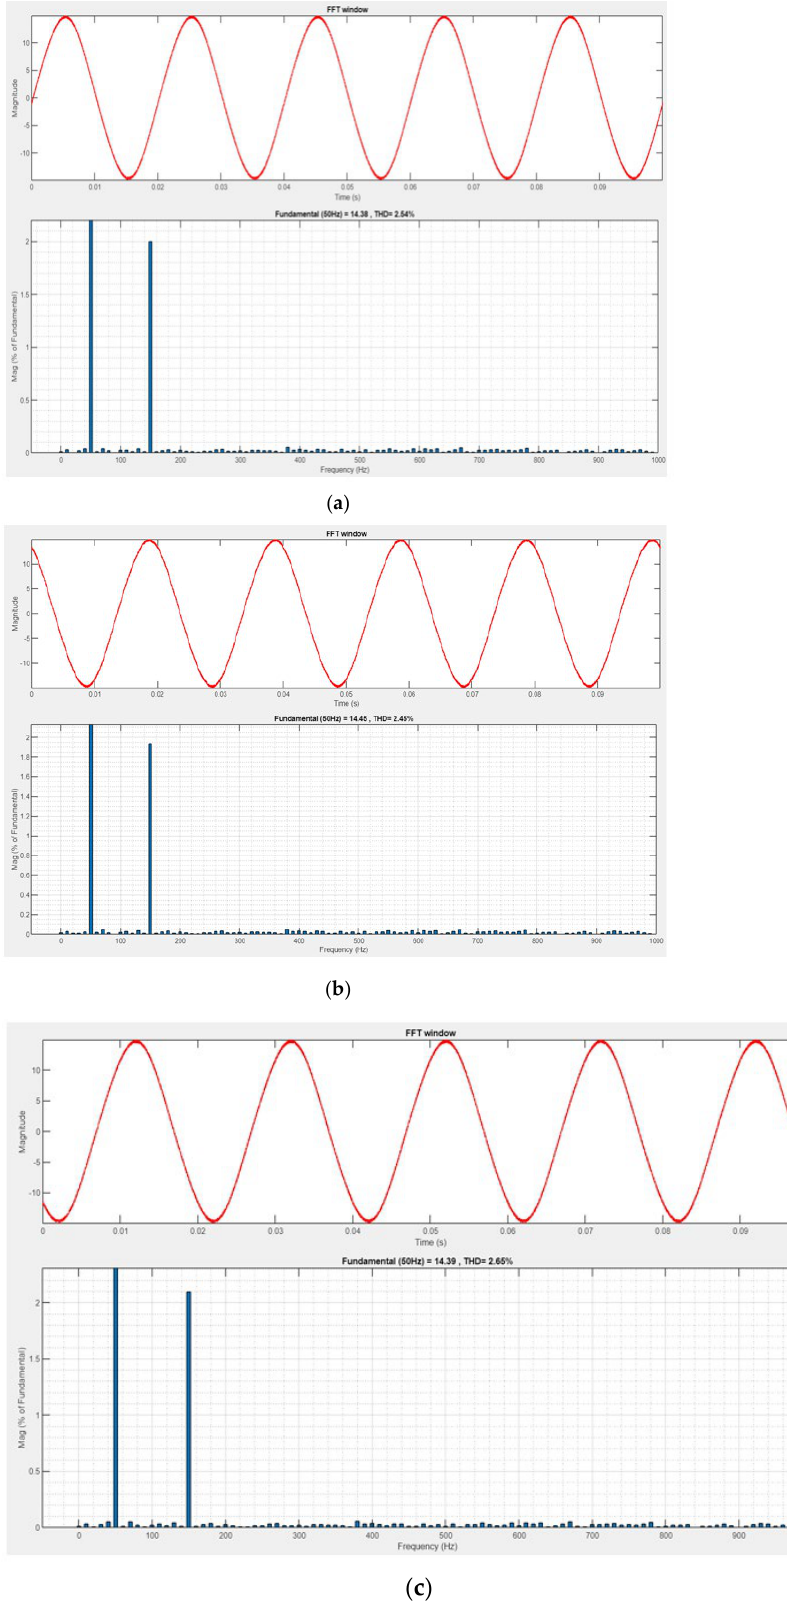
Figure 9. ( a ) THD of A-phase Source current ( b ) THD of B-phase Source current ( c ) THD of C-phase Source current.